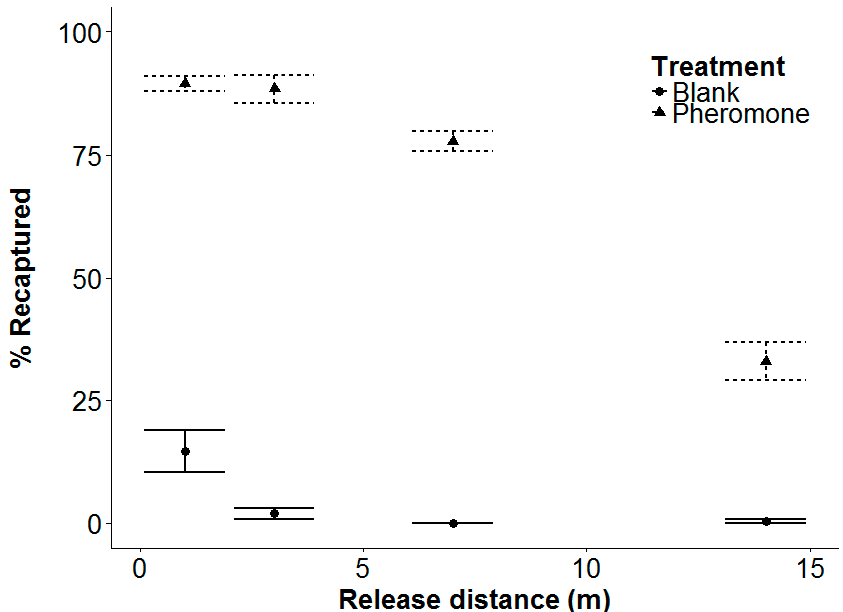
Figure 4. Mean proportion ( ± SE) of Agriotes obscurus beetles recovered after release from 1, 3, 7, and 14 m away from a band of blank or pheromone granules. N = 4 per treatment. The final model is % recovered = 4.0045 (pheromone) − 0.693 (distance) + 0.4396 (release side) +/ − 0.4513(distance × pheromone) − 1.480. Table 3. Mean time (hours ± SE) to maximum recaptures for Agriotes obscurus beetles released at different distances away from a pheromone granule band (N = 4).